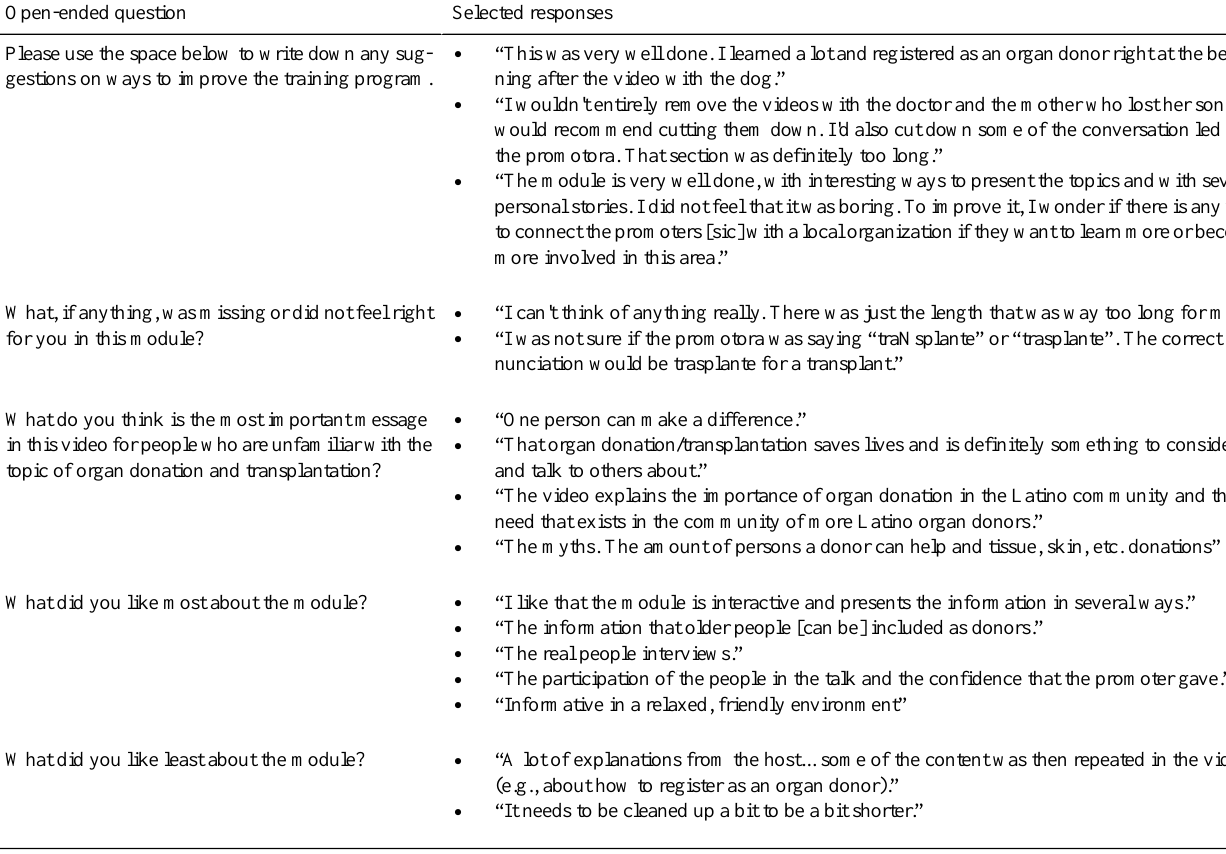
Table 3. Selected responses to open-ended questions.